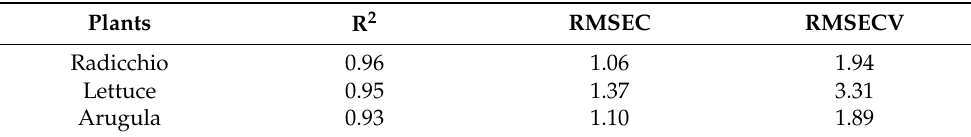
Figure 10. Bot menu and productivity prediction for the three plant species. Table 4. Prediction results.